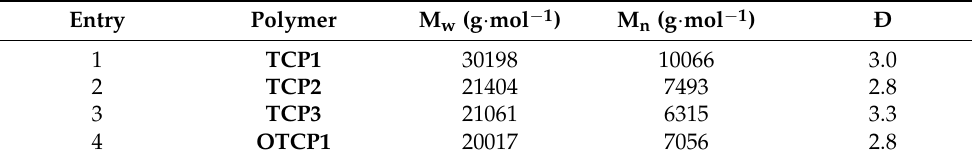
Table 1. Summary of the GPC results of the copolymers TCP1–3 and OTCP1